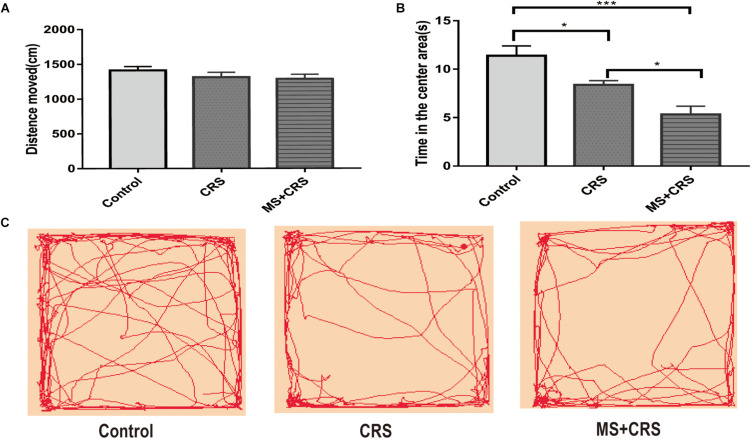
Behavioral changes during the open field test (OFT). (A) Means of distance moved and (B) Time in the center area. (C) Representative video tracking images during 5 min in the OFT. Data are presented as the mean ± SEM. n = 9–10 mice in each group. *P < 0.05, ***P < 0.001.